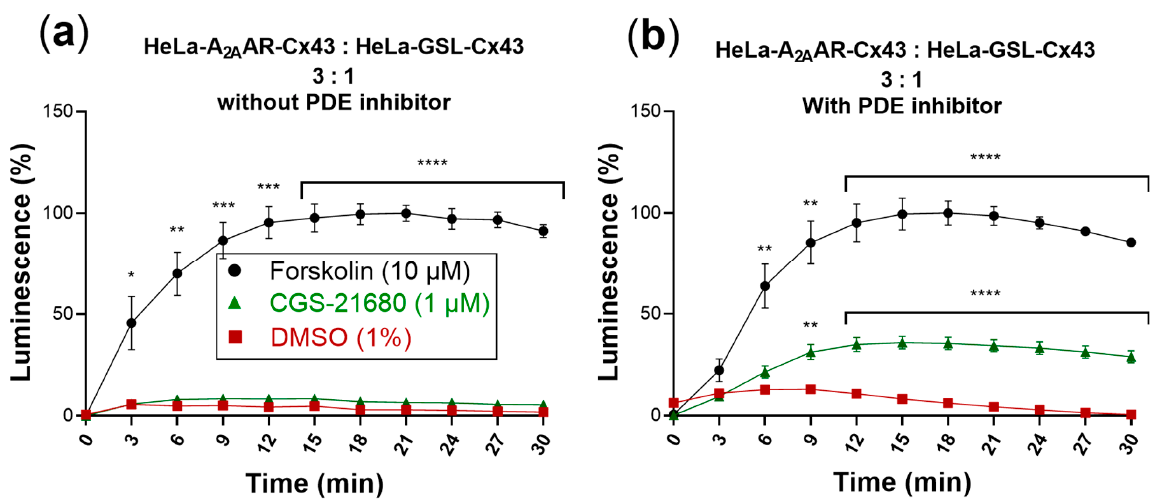
Figure 6. cAMP ‐ dependent luminescence signal due to activation of cocultures of donor and biosensor cells (3:1) by the selective A 2A AR agonist CGS-21680 (1 µ M). Forskolin (10 µ M) was used as positive control and DMSO (1%) served as negative control. Data are normalized to the maximal effect of forskolin (100%). Data represent means ± SEM of three individual experiments performed in duplicates. ( a ) Activation without PDE inhibitor. Only forskolin displayed a significantly increased luminescence signal compared to control. ( b ) Activation in the presence of the PDE inhibitor IBMX (200 µ M). Statistical significance calculated with repeated measures 2-way ANOVA and Dunnet’s multiple comparisons test comparing treatments to control (DMSO, 1%). * p < 0.05, ** p < 0.01, *** p < 0.001, **** p < 0.0001.